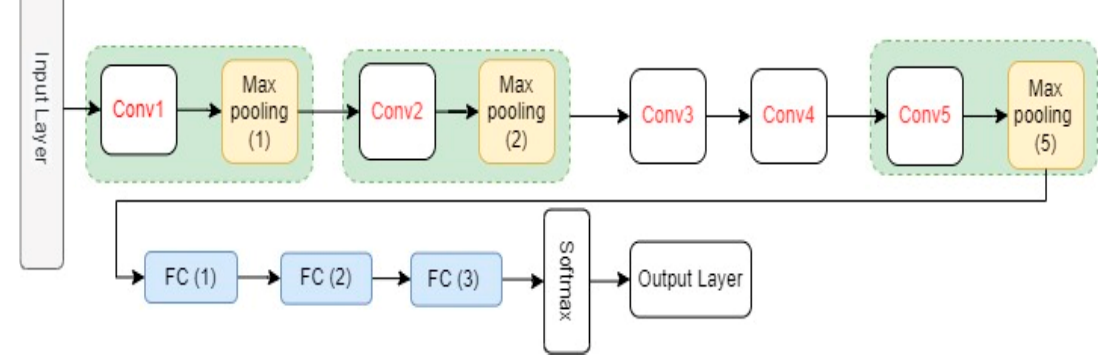
Figure 3. The architectures of AlexNet. Table 1. The original AlexNet model architecture.